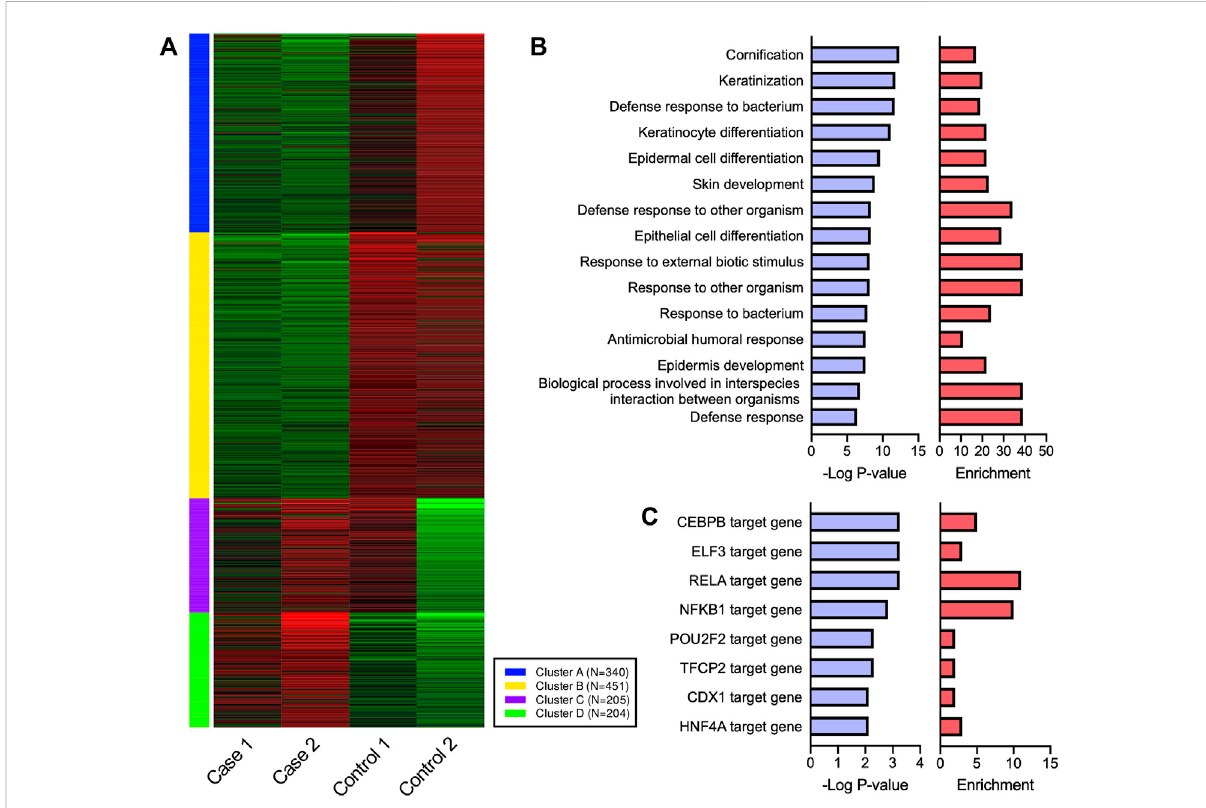
FIGURE 3 Transcriptional pro fi les of HHD and healthy control skin. (A) Four gene clusters identi fi ed by k-means based on the most variable 1,200 genes. (B,C) GO terms and TRRUST transcription factor-target interactions enriched in cluster D. RELA and NFKB1 are major components of NF- κ B